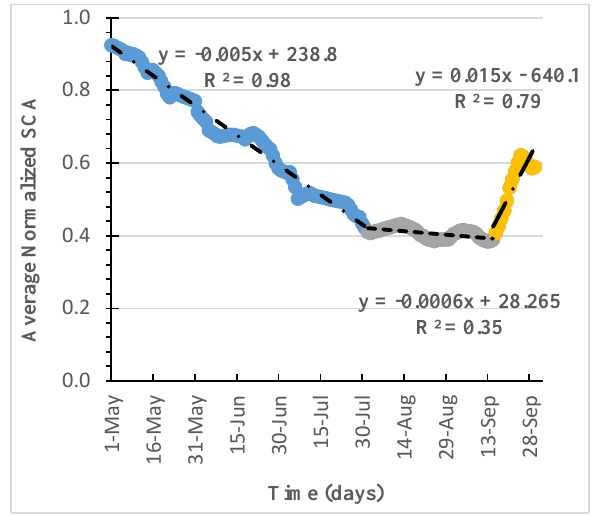
Figure 5. SDC for melt season of 2013 to 2018 and average normalized SCA for a period of 6 years